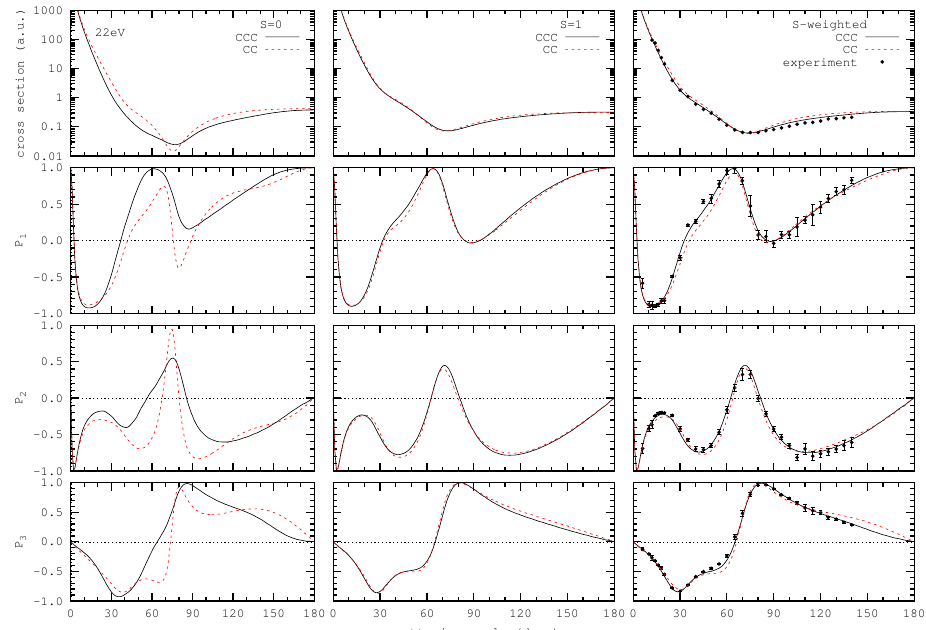
Figure 3. Same as for Figure 1, except for 22